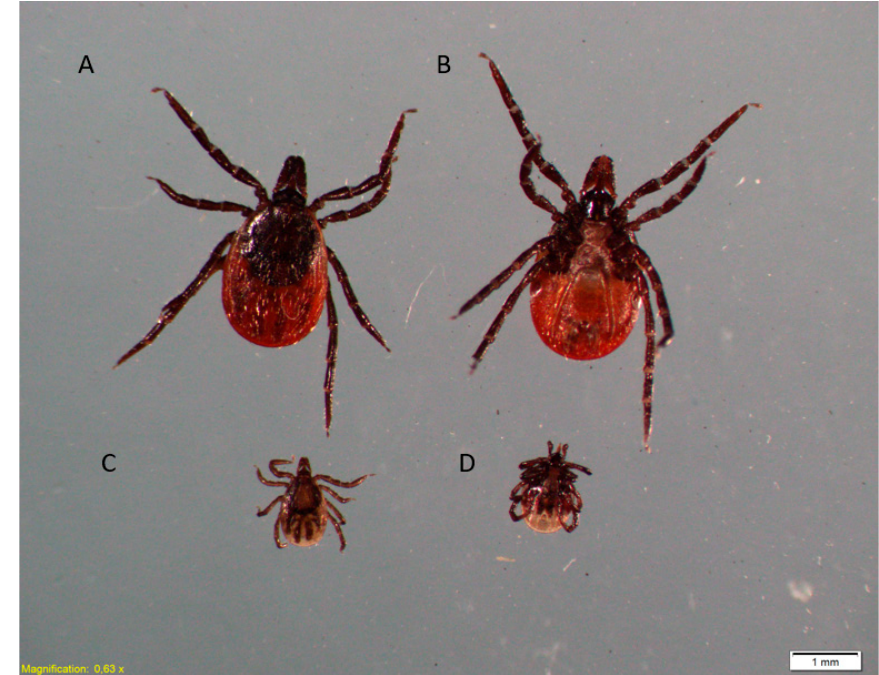
Figure 3. Ixodes ricinus female. Dorsal side ( A ) and ventral side ( B ). Nymph. Dorsal side ( C ) and ventral side ( D ).